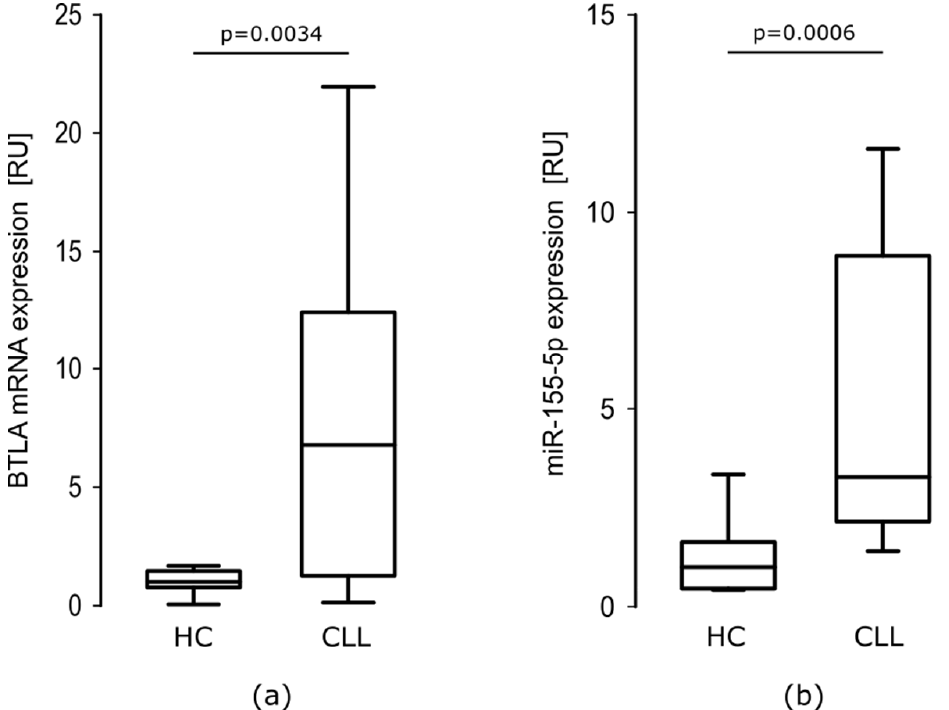
Figure 2. BTLA mRNA and miR-155-5p expression are elevated in CLL PBMCs. ( a ) BTLA mRNA is overexpressed in CLL PBMCs ( n = 20) about 6-fold comparing to healthy controls (HC) PBMCs ( n = 15) ( p = 0.0034, Mann–Whitney test); ( b ) miR-155-5p expression level is upregulated about 3-fold in CLL PBMCs ( n = 20) when compared to HC PBMCs ( n = 15) ( p = 0.0006, Mann–Whitney test). The central line shows the median, whiskers represent from the first quartile to the third quartile. miR-155-5p Is Overexpressed in CLL Patients As previously shown in literature [26] the miR-155-5p is overexpressed in CLL patients compared to HC. In our study, in CLL PBMCs miR-155-5p relative expression ranged from 1.011–17.370 RU with a median of 3.274 RU, while in HC PBMCs, the levels of miR-155-5p ranged from 0.396–3.349 RU with a median of 1.000 RU. The difference between groups was statistically significant ( p = 0.0006) (Figure